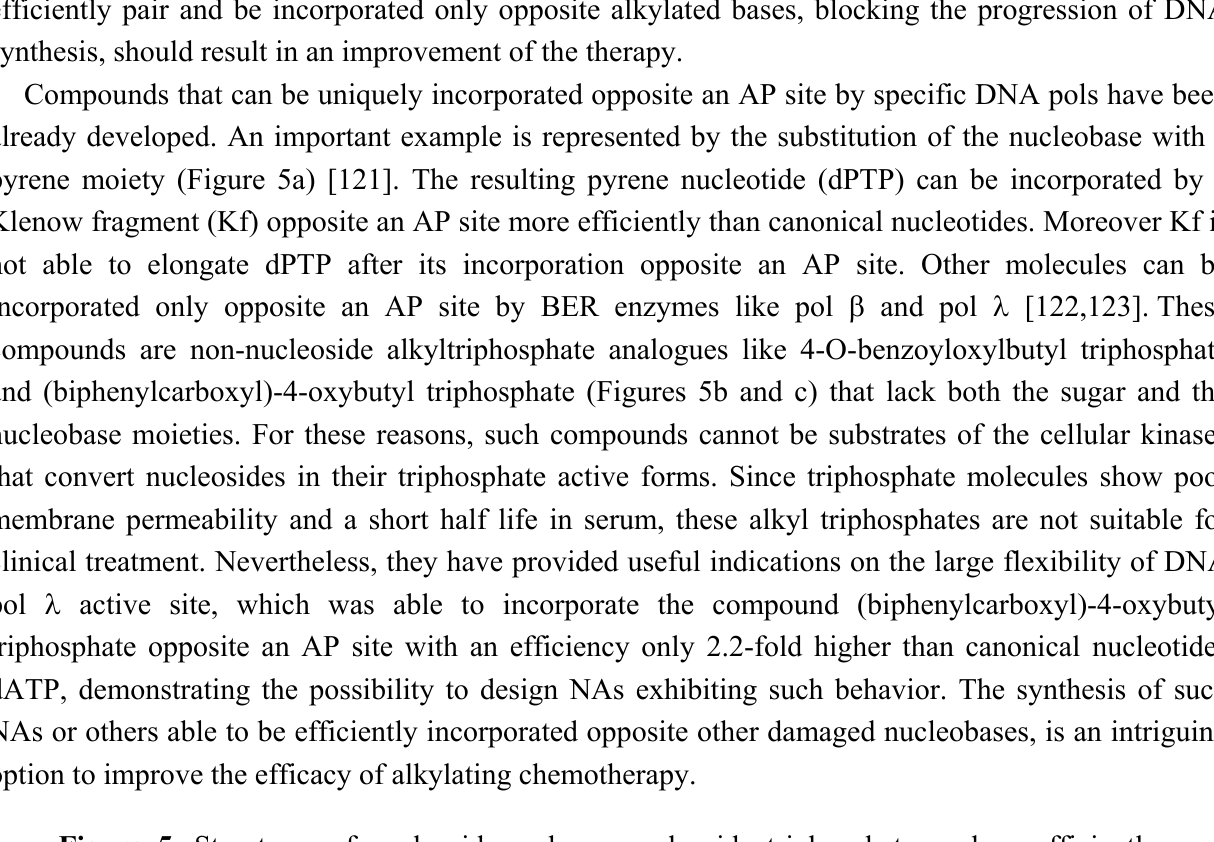
Figure 5. Structures of nucleoside and non-nucleoside triphosphate analogs efficiently pairing with AP site. ( a ) Pyrene nucleotide (dPTP); ( b ) 4-O-benzoyloxylbutyl triphosphate; ( c ) (biphenylcarboxyl)-4-oxybutyl